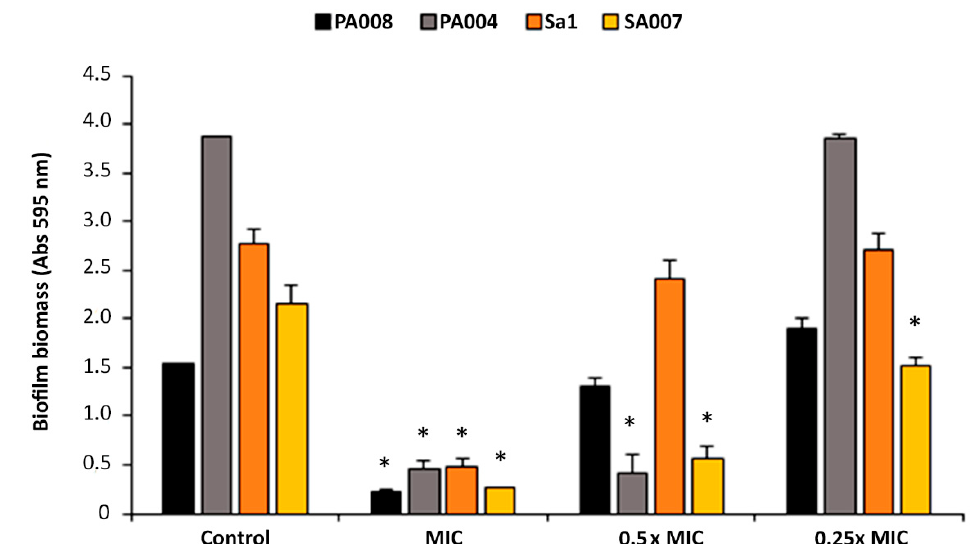
Figure 1. Biomass quantification through the crystal violet assay of biofilms formed by two P. aeruginosa and two methicillin-resistant S. aureus (MRSA) isolates in presence of peptide Hs02. Biofilms were formed in the presence of different concentrations (ranging from the MIC to 0.25× MIC) of peptide Hs02. Two independent experiments were performed in triplicate. Error bars represent SD. Statistically significant differences in comparison to the control ( p < 0.05) are marked with an asterisk (*). Abs: Absorbance.